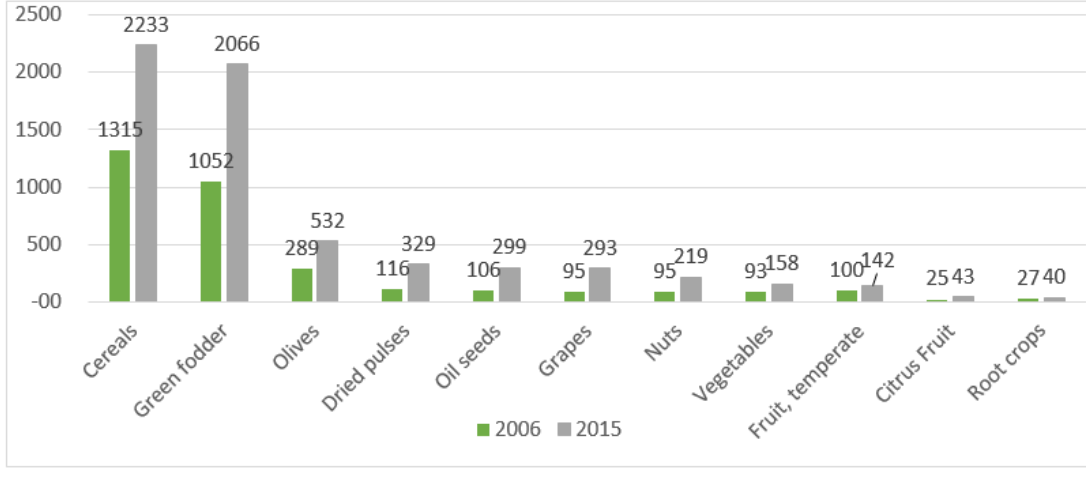
Figure 2. Development of selected crop groups in Europe 2006–2015 (thousand hectares). Source: FiBL-AMI survey 2016.